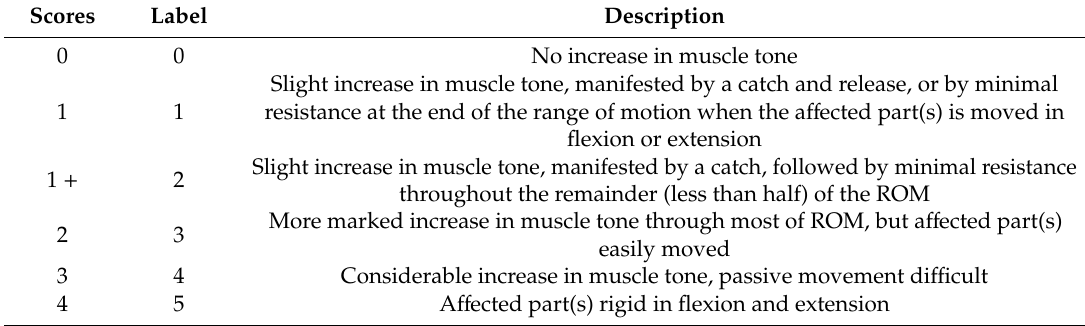
MAS scoring description and corresponding labels of the MAS scores used for supervised